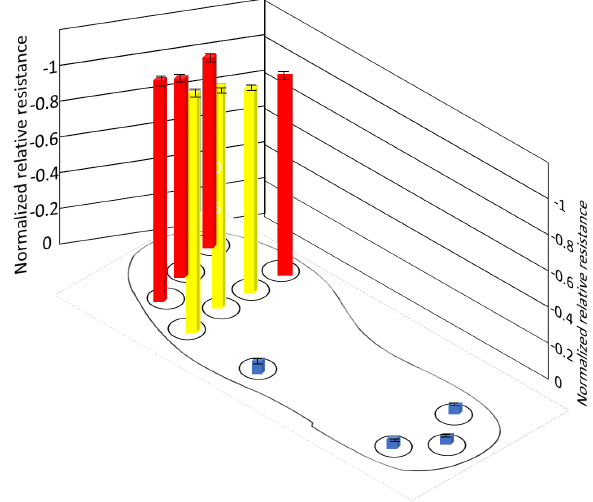
Figure 15. Normalized resistance of sensors during position